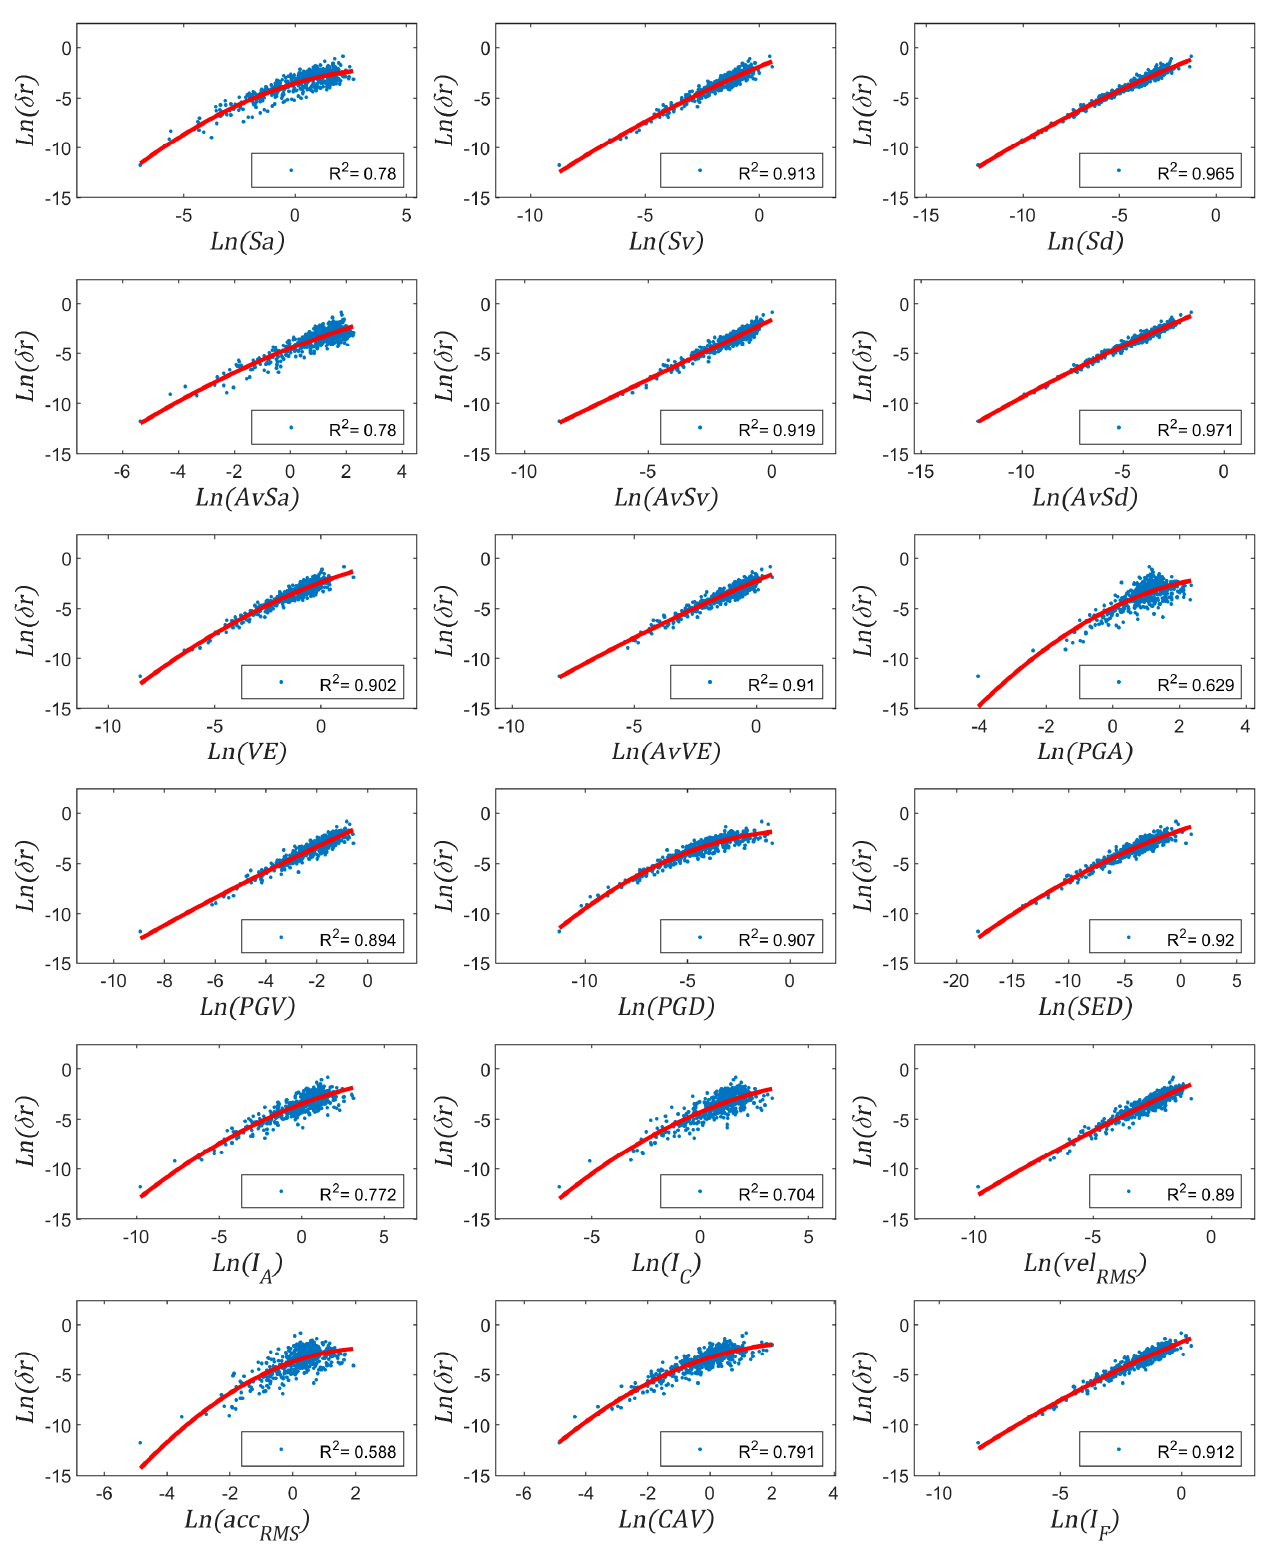
Figure 8. Correlation coefficient between IMs and δr in the log-log space for far-fault records.